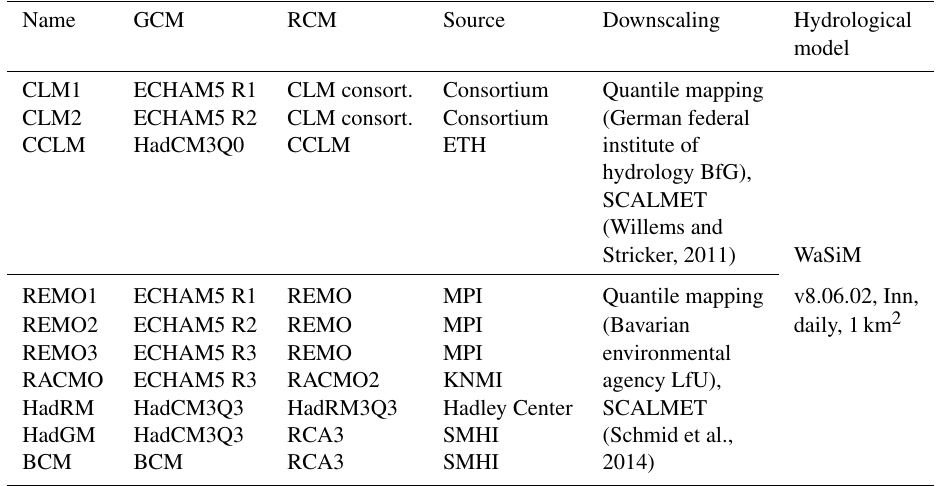
Table 1. RCMs used in this study, driving GCMs, source of the RCMs, downscaling and hydrological model. R1–R3 denote distinct model runs. Name GCM RCM Source Downscaling Hydrological model CLM1 ECHAM5 R1 CLM consort. Consortium Quantile mapping CLM2 ECHAM5 R2 CLM consort. Consortium (German federal CCLM HadCM3Q0 CCLM ETH institute of hydrology BfG), SCALMET (Willems and Stricker, 2011) WaSiM REMO1 ECHAM5 R1 Quantile mapping v8.06.02, Inn, ECHAM5 R3 environmental agency LfU), Hadley Center